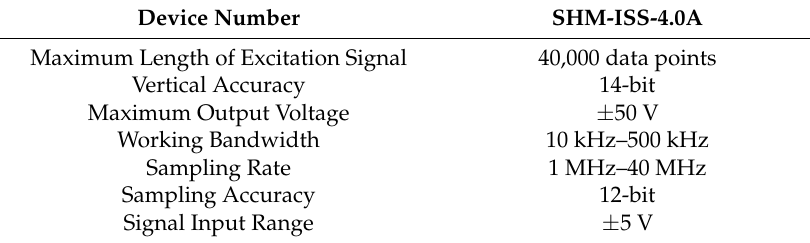
Table 1. Piezoelectric monitoring equipment technical indicators.